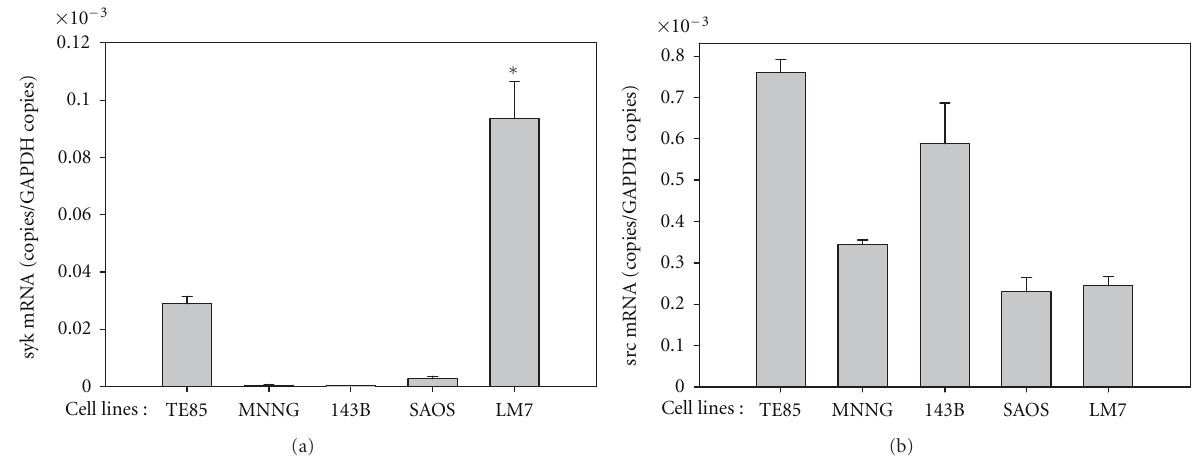
Figure 7: Expression of syk (a) and src (b) mRNA levels in the osteosarcoma cell lines at mid-log phase. mRNA levels were normalized to those of GAPDH. The asterisk denotes P < 0 . 001 compared with the mRNA levels of the non-metastatic SAOS-2 cell line. Each reaction was performed in